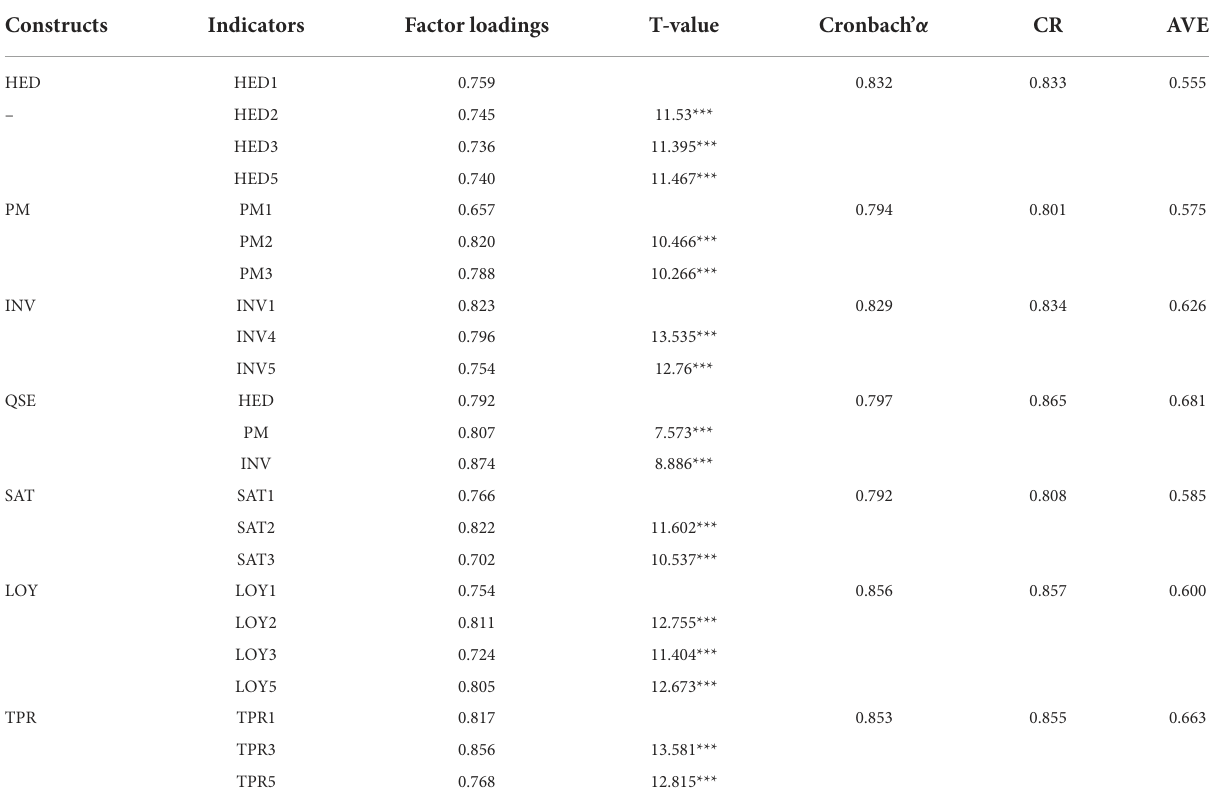
TABLE 2 Constructs and corresponding items, loadings, and reliability scores.